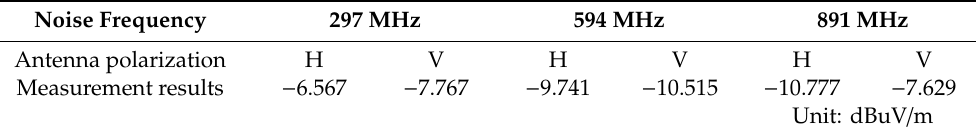
Table 2. EMI measurement data after HDMI layout